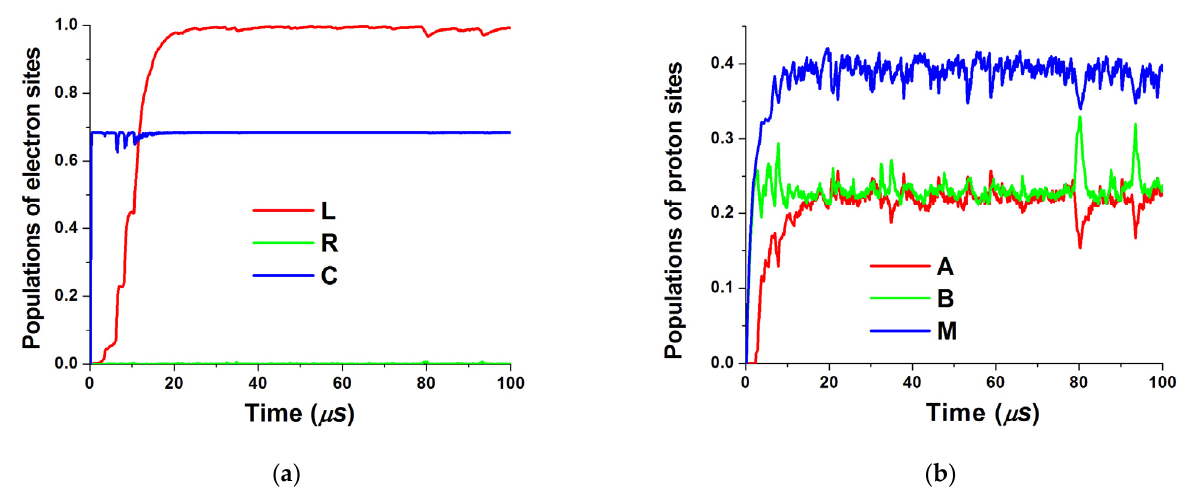
Figure 4. Time dependencies of site populations. ( a ) Populations of electron sites L , R , and C ; ( b ) populations of proton sites A , B , and M .